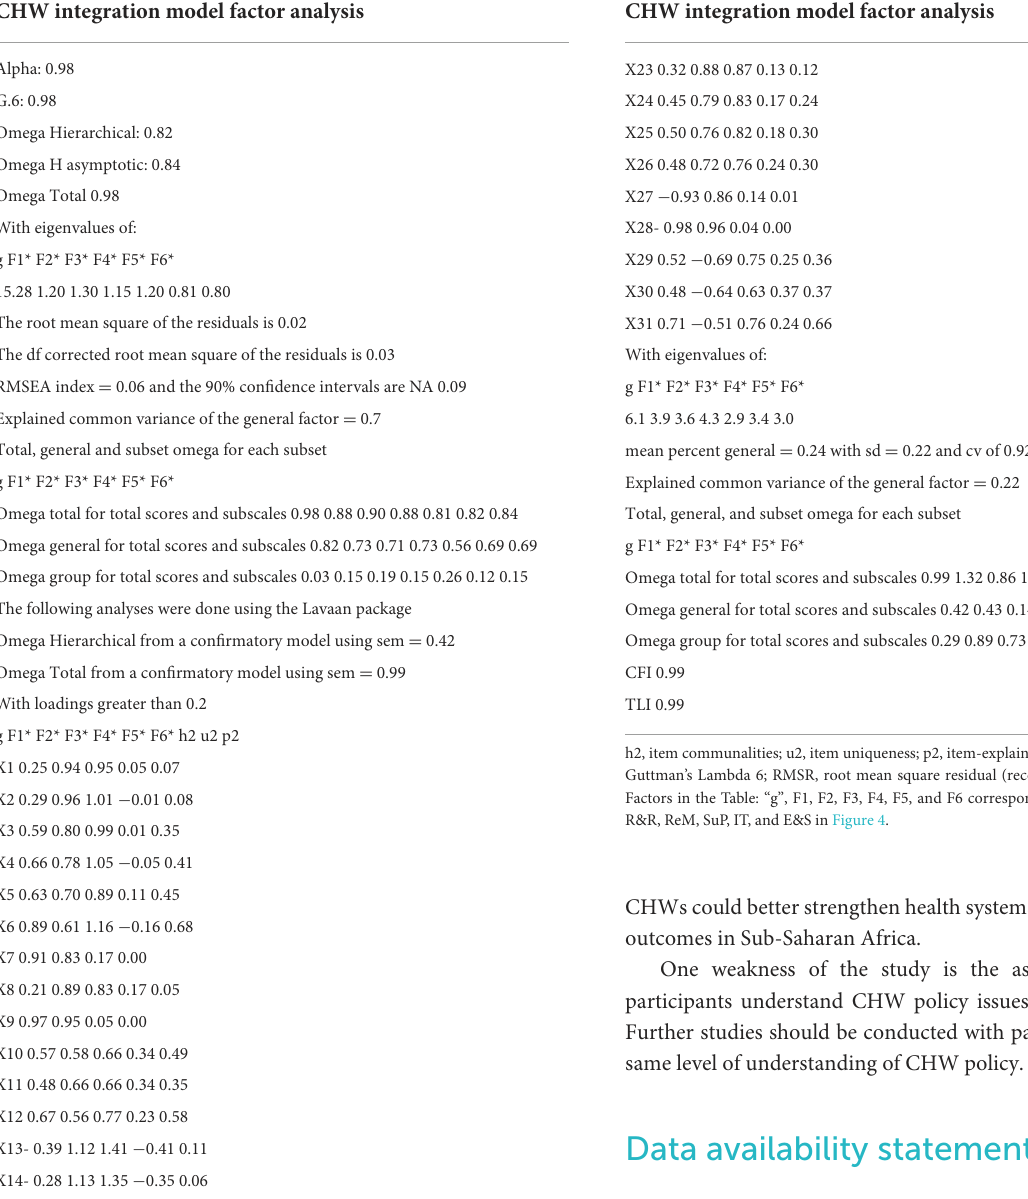
TABLE 2 Exploratory and confirmatory bifactor